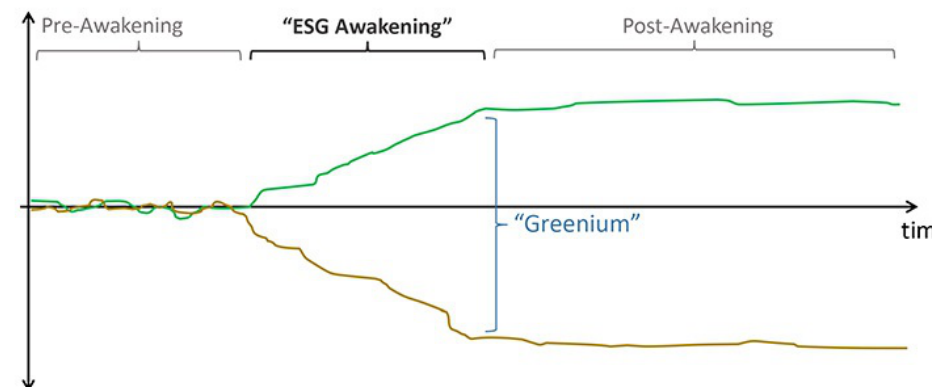
Figure 1. Green Inc. and Brown Inc. Stock Prices, Source: KI